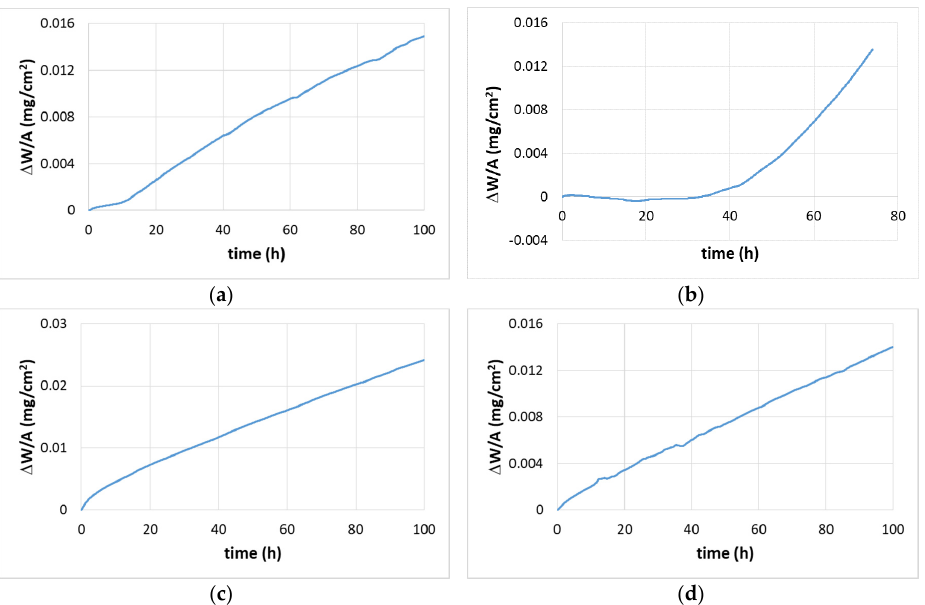
Figure 6. BSE images of the microstructure of the heat-treated alloy JZ3+ ( a ) in the bulk and ( b ) below the surface.